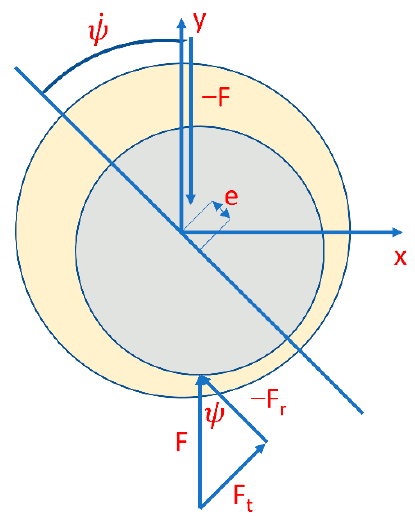
Figure 1. Journal bearing geometry.